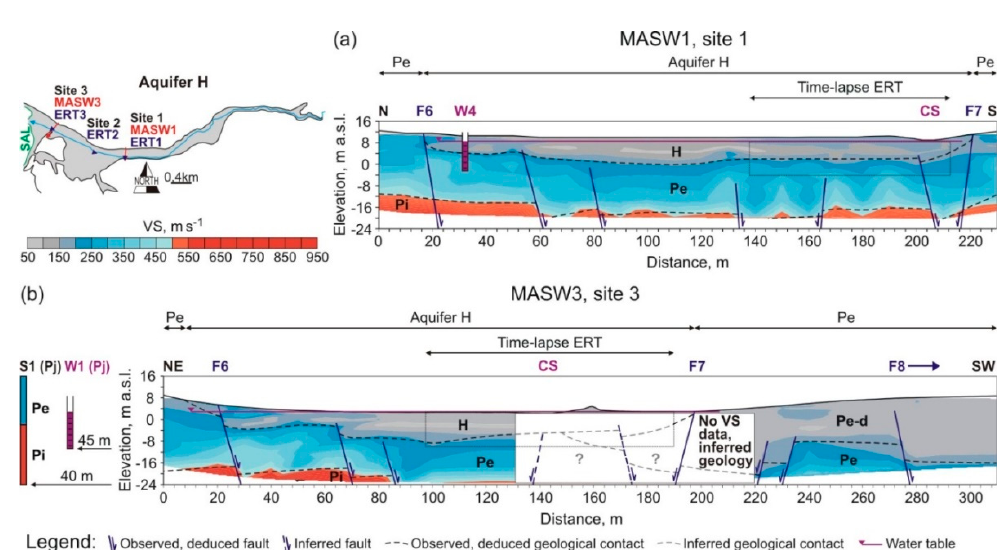
Figure 5. MASW1 and MASW3 surveys at sites 1 ( a ) and 3 ( b ), respectively. A preliminary geological interpretation of VS values is included, showing projected (Pj) log of geotechnical sounding S1 after [40], and water table recorded in September 2014 in wells W4 (site 1) and W1 (site 3) as in Figure 4. Profiles are topographically corrected and its vertical-to-horizontal scale ratio is 1:1. CS, Cascalheira Stream; H, Holocene; Pe, Pleistocene; Pe-d, Pleistocene sand dunes; Pi, Pliocene; and F1 to F3, NW–SE strike-slip faults. The dotted-line rectangle is the area covered by time-lapse ERT surveys at sites 1 and 3.